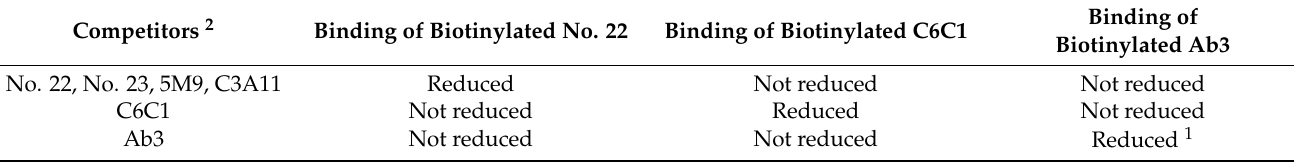
Figure 4. Western blotting with SFTS virus Gn and Gc proteins under reduced condition. Three mAbs, anti- Strep Tag II, 4M5, and M1-E5, were used as primary antibodies. Table 4. Competition ELISA with anti-Gc mAbs 1